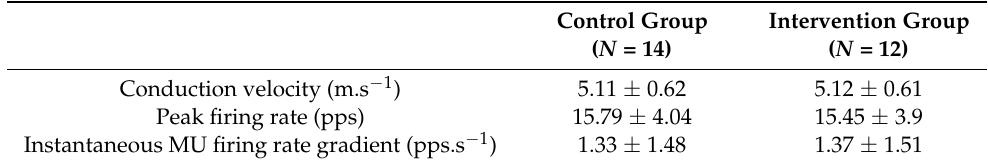
Table 1. Baseline measurements before Intervention (mean ± SE) .